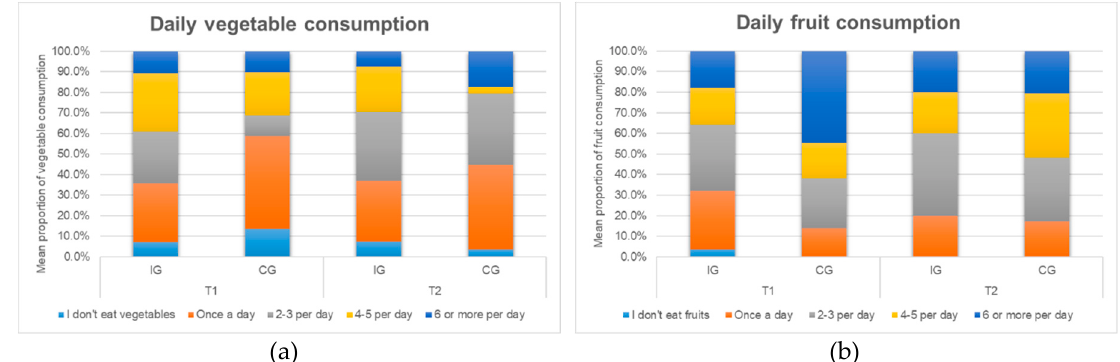
Figure 6. (a) Daily vegetable consumption of children before and after intervention. (b) Daily fruit consumption of children before and after intervention.